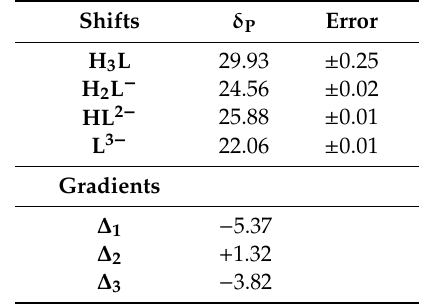
Table 12. Gradients Δ i of specific chemical shifts δ P [ppm] of 7c . Experimental data: C Titrand : 0.010 mol/L of 7c . C Titrator : 0.10 mol/L TMAOH.